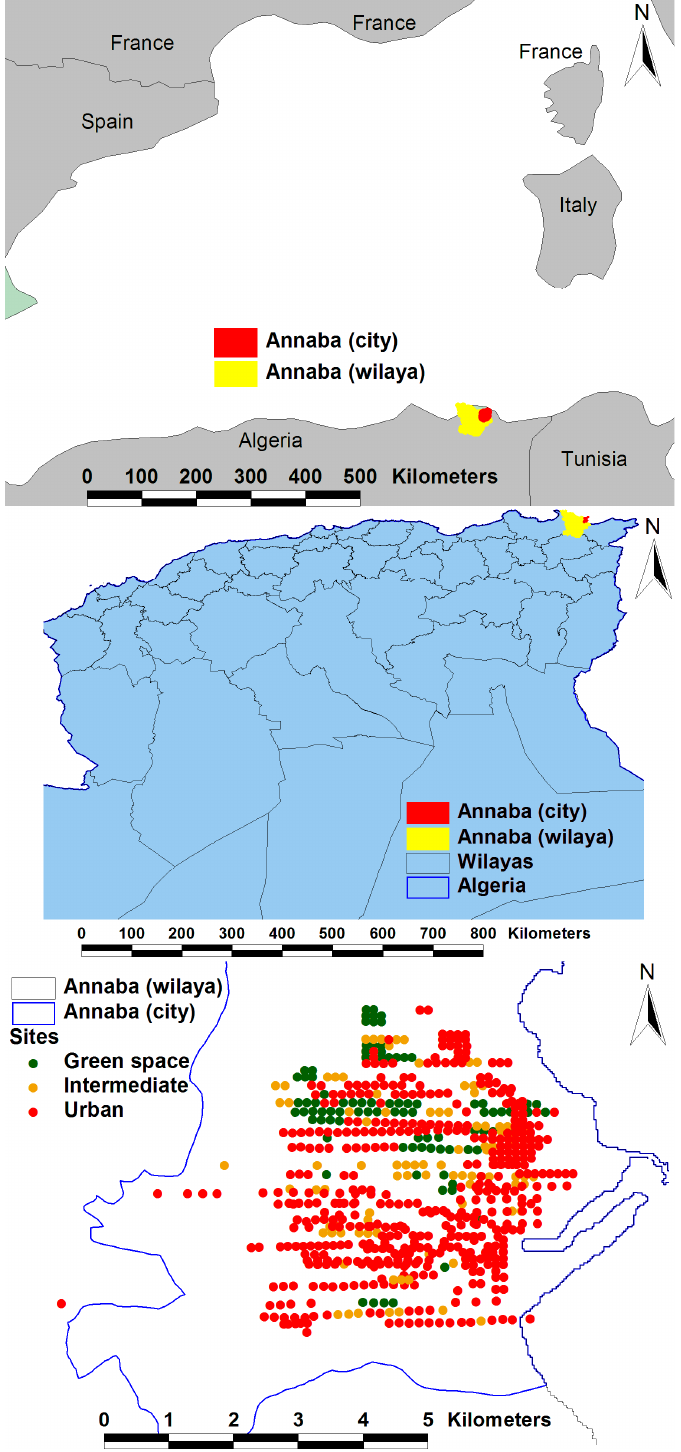
Figure 1. Location of the case study in an international ( top ) and national context ( middle ), and of the sampling sites ( bottom ).